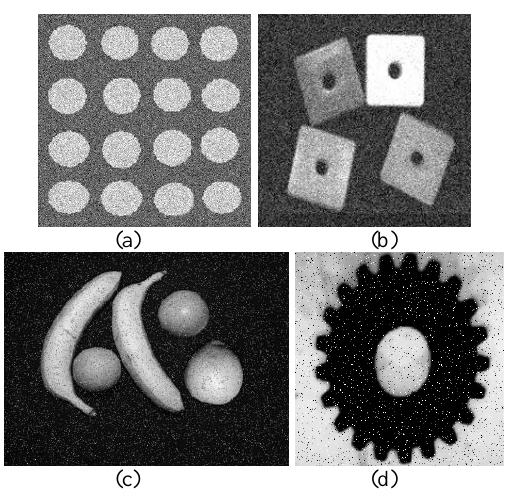
Fig. 10. The noisy images: (a) circle_n; (b) block_n; (c) fruits_n; (d) gearwheel_n